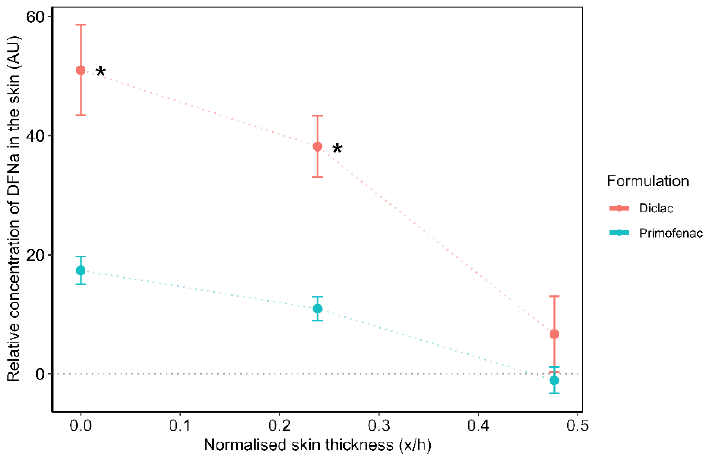
Figure 3. Depth profiles of DFNa (AU) across the SC estimated by CRS following a 30 min applica- tion of formulations in vivo (mean ± SEM of 2 subjects; n ≥ 6 replicates per subject; * p < 0.05). Both formulations were found to promote DFNa penetration to the SC over 30 min.